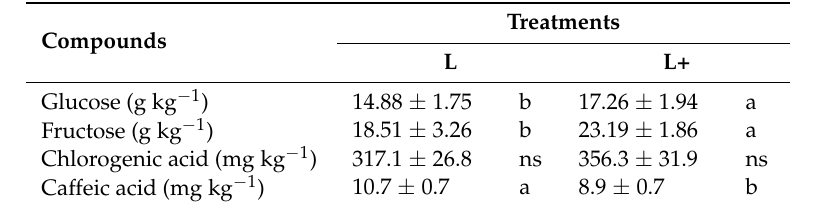
Table 2. Sugars and phenolic acid content in the dry biomasses of the monocultured and intercropped lettuces. Different letters indicate significant differences ( p < 0.05) among treatments for each parameter, according to the Tukey’s HSD test. ns = not significant